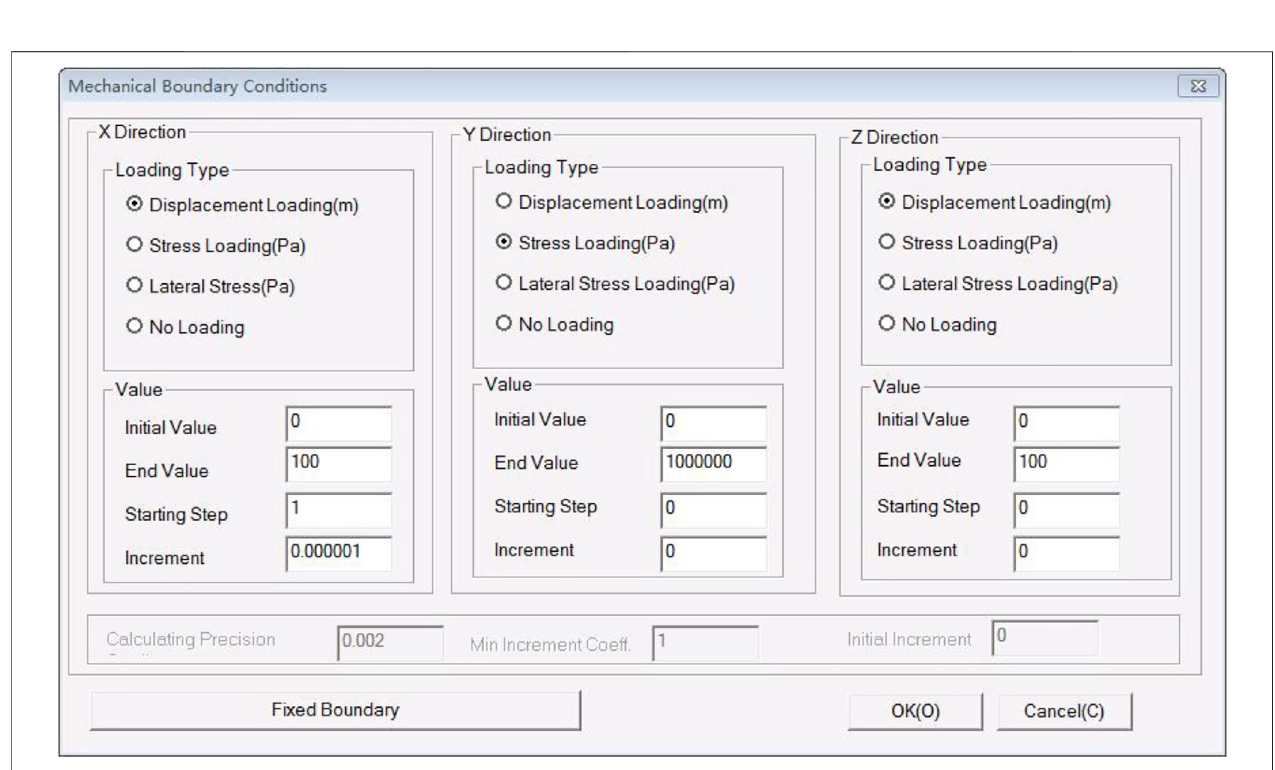
FIGURE 5 | Loading method of the specimen.